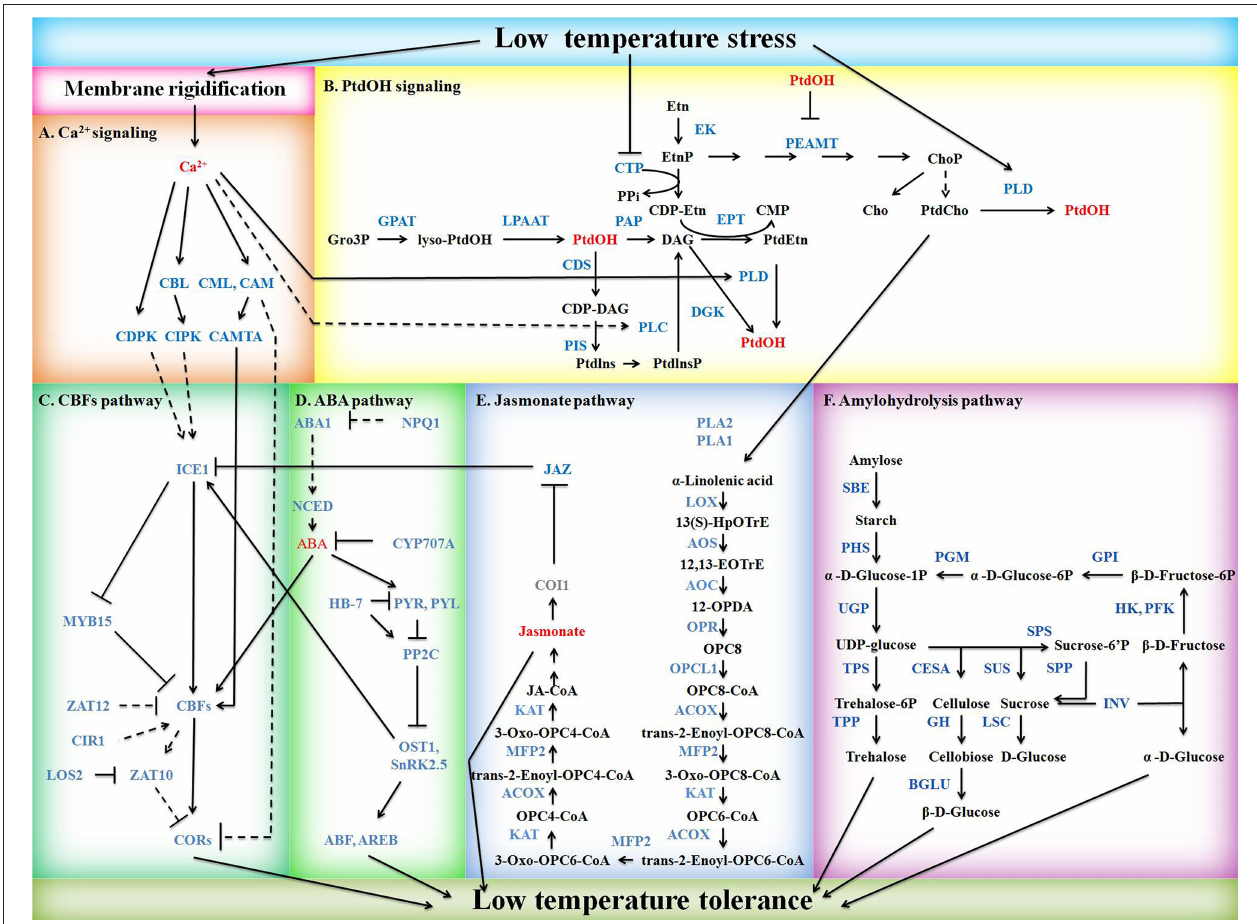
FIGURE 1 | Schematic diagram of potential mild freezing shock signaling pathways in barley. Signaling molecules, DEGs, non-DEGs, and metabolites or others are shown in red, blue, gray, and black, respectively. Solid arrows indicate positive regulation whereas lines ending with a bar stand for negative regulation. Regulations are direct (solid line) or indirect (dash line). (A) Ca 2 + signaling. CAM, calmodulin; CAMTA, calmodulin-binding transcription factor; CBL, calcineurin B-like protein; CDPK, calcium-dependent protein kinase. CIPK, CBL-interacting protein kinase; CML, calmodulin-like protein. (B) PtdOH signaling. CDS, cytidine diphosphate-diacylglycerol synthase; CTP, phosphorylcholine cytidylyltransferase; DGK, diacylglycerol kinase; EK, ethanolamine kinase; EPT, cytidine diphosphate-ethanolamine phosphotransferase; GPAT, glycerol 3-phosphate acyltransferase; LPAAT, lysophosphatidic acid acyltransferase; PAP, phosphatidic acid phosphatase; PEAMT, phosphoethanolaminemethyltranferase; PIS, phosphatidylinositol synthase; PLC, phospholipase C; PLD, phospholipase D; PtdOH, phosphatidic acid. (C) CBFs pathway. CBF, C-repeat binding factor; CIR1, circadian 1; COR, cold responsive genes; ICE1, inducer of CBF expression 1; LOS2, low expression of osmotically responsive genes 2; MYB15, Myb domain protein 15. (D) ABA pathway. ABA1, ABA deficient 1; ABF, ABA-responsive elements-binding factor; AREB, ABA-responsive element-binding protein; CYP707A, cytochrome P450-family 707-subfamily A; HB-7, homeobox-7; NCED, nine-cis-epoxycarotenoid dioxygenase; NPQ1, non-photochemical quenching 1; OST1, open stomata 1; PP2C, protein phosphatase 2C; PYL, pyrabactin resistance 1-like; PYR, pyrabactin resistance; SnRK2.5, sucrose non-fermenting 1-related protein kinase 2.5. (E) Jasmonate pathway. ACOX, acyl-CoA oxidase; AOC, allene-oxide cyclase; AOS, allene oxide synthase; COI1, coronatine insensitive 1; JAZ, jasmonate-zim-domain protein 11; KAT, ketoacyl-CoA acyltransferase; LOX, linoleate 13S-lipoxygenase; MFP2, enoyl-CoA hydratase; OPCL1, OPC-8:0 CoA ligase 1; OPR, 12-oxophytodienoate reductase; PLA1, phospholipase A1; PLA2, phospholipase A2. (F) Amylohydrolysis pathway. BGLU, beta-glucosidase; CESA, cellulose synthase; GH, 4-beta-D-glucan 4-glucanohydrolase; GPI, glucose-6-phosphate isomerase; HK, hexokinase; INV, invertase; LSC, levansucrase; PFK, phosphofructokinase; PGM, phosphoglucomutase. PHS, alpha-glucan phosphorylase; SBE, starch branching enzyme; SPP, sucrose-phosphate phosphatase; SPS, sucrose-phosphate synthase; SUS, sucrose synthase; TPP, trehalose-6-phosphate phosphatase; TPS, trehalose-6-phosphate synthase; UGP, UDP-glucose